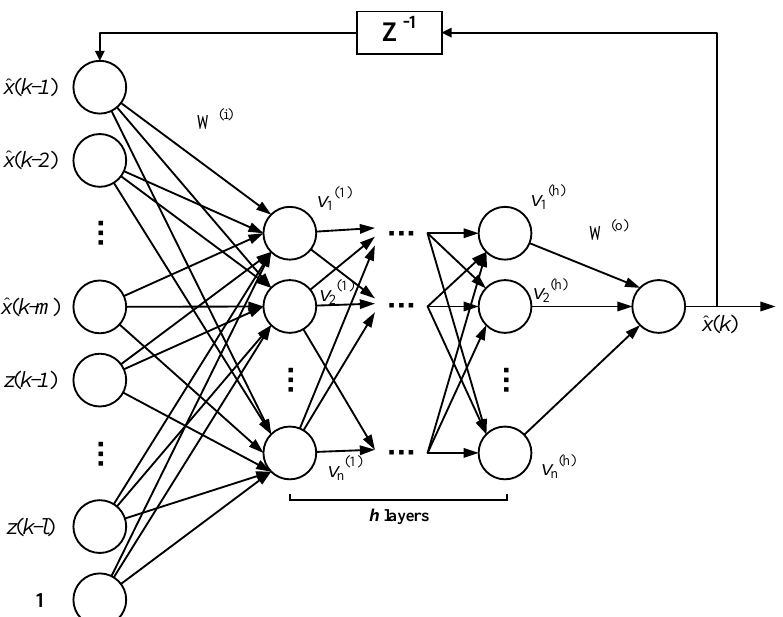
Figure 3. Parallel nonlinear autoregressive model with exogenous inputs (NARX) structure with h hidden layers and recursive feedback. The nodes of each hidden layer are n . d is the output estimated data in the time sequence, and m is the output depth. u is the measured input data in the time sequence, and l is the input depth. The maximum delay of the out-of-sequence l max should be no more than l